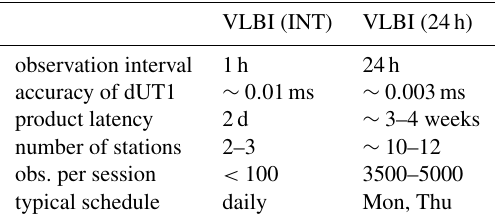
Table 1. Common characteristics of VLBI Intensive and 24h ses- sions (Baver et al., 2017).